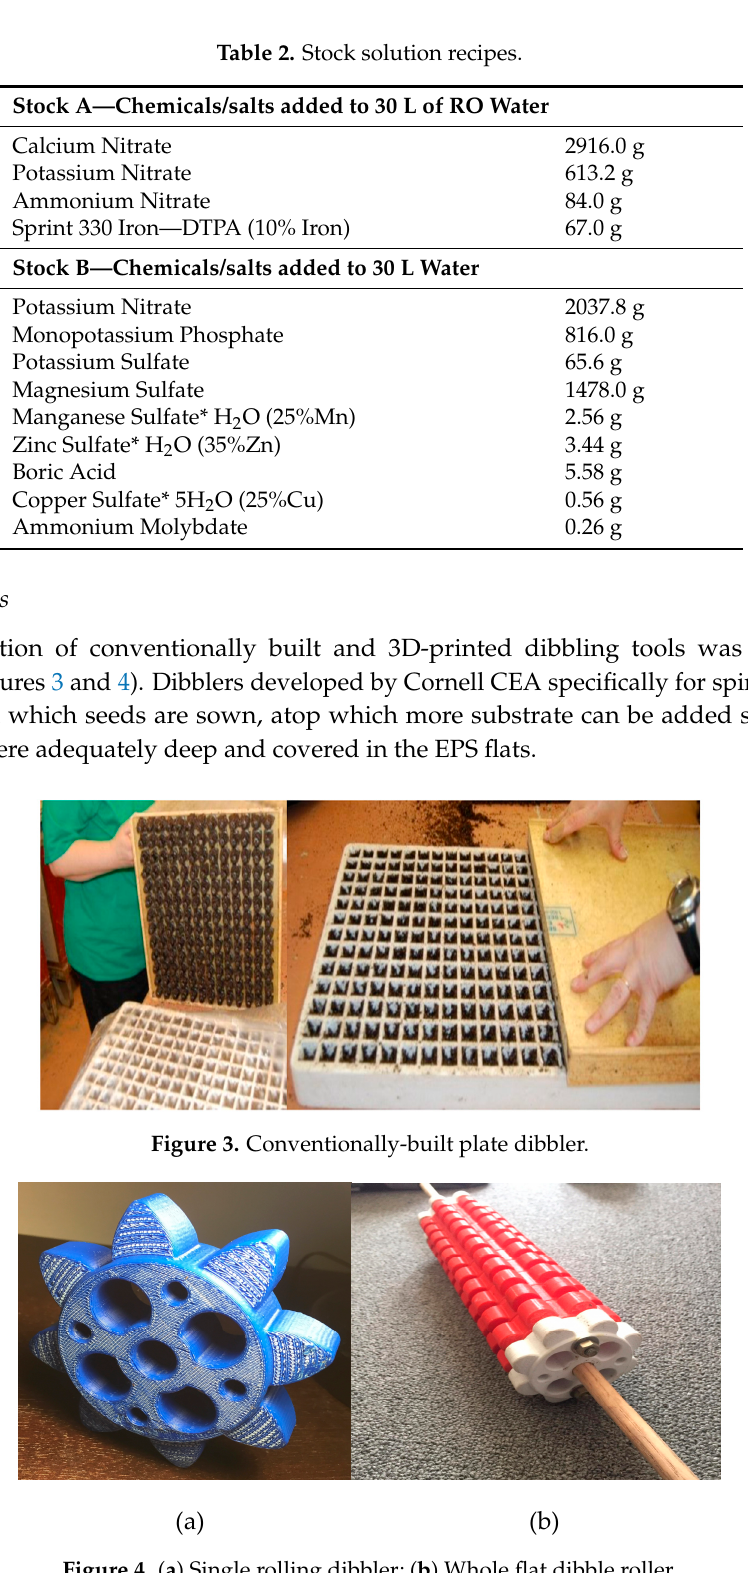
Figure 4. ( a ) Single rolling dibbler; ( b ) Whole flat dibble roller.